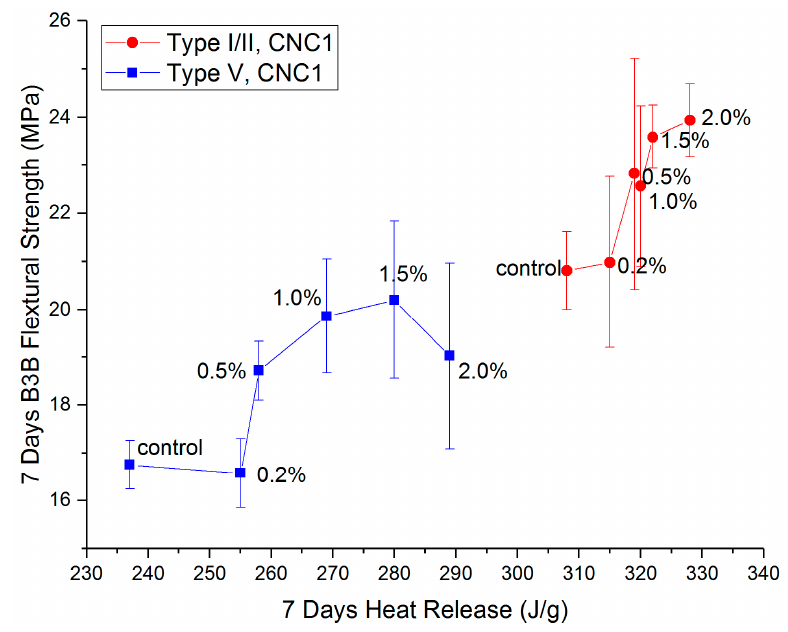
Figure 9. Comparison between B3B flexural strength and heat release for CNC1 with Type I/I and Type V cements .